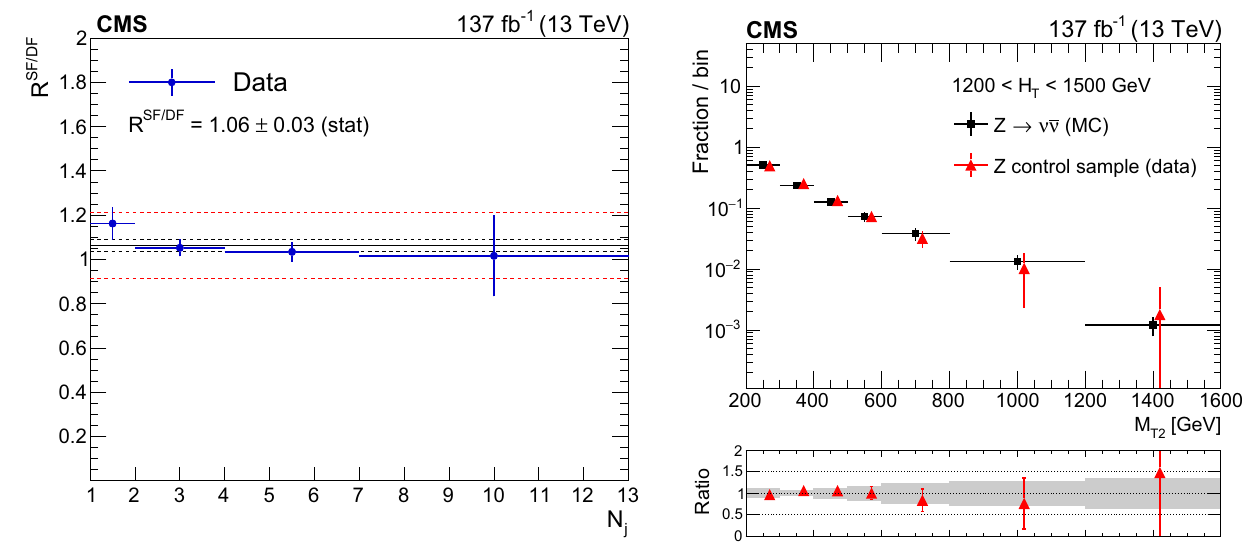
Fig. 2 (Left) Ratio R SF / DF in data as a function of N j . The solid black line enclosed by the red dashed lines corresponds to a value of 1 . 06 ± 0 . 15 that is observed to be stable with respect to event kinematic variables, while the two dashed black lines denote the statistical uncer- tainty in the R SF / DF value. (Right) The shape of the M T2 distribution in